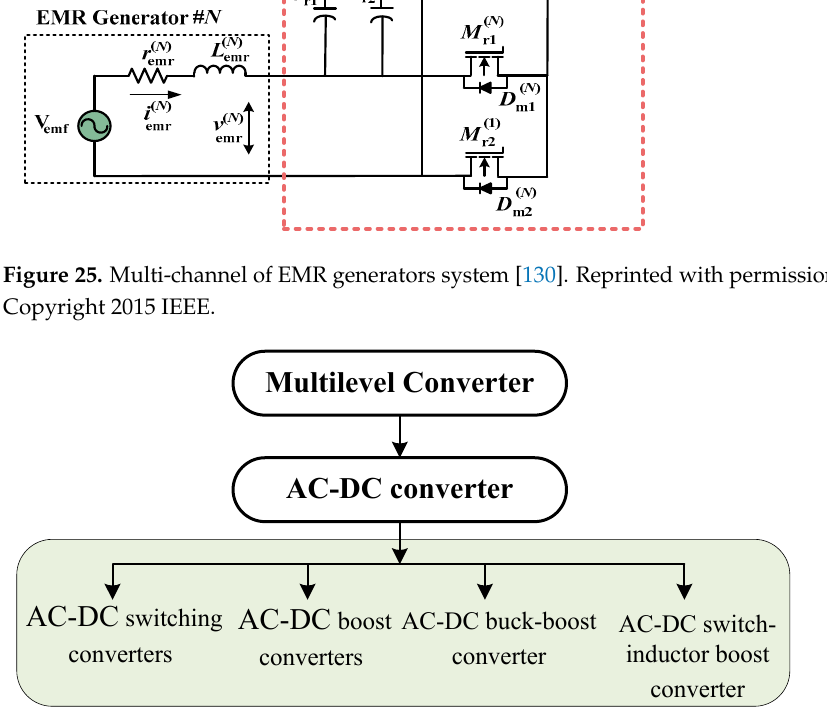
Figure 26. Classification of multilevel